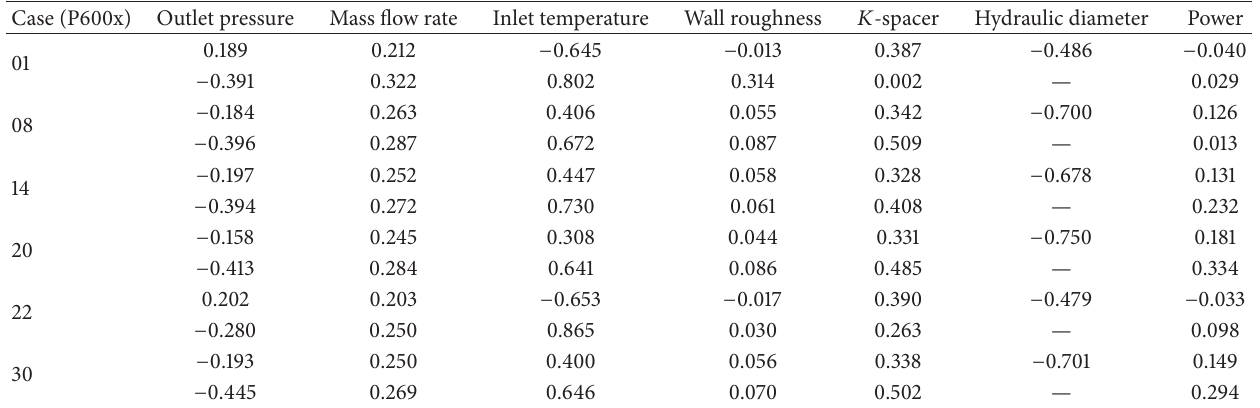
Table 6: Sensitivity coefficients for the two-phase flow pressure drop.